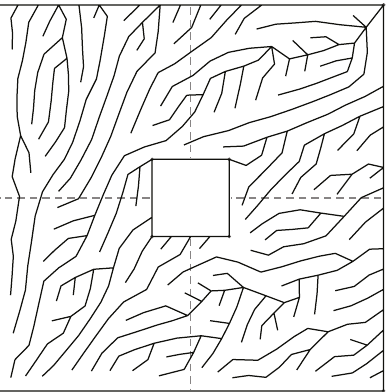
Figure 4: A mesh of a square with a hole after cell combining. Loose tails are left behind, which can be removed with p -Reduce